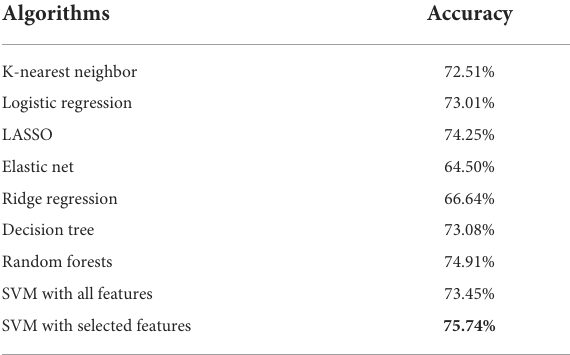
TABLE 4 Average classification accuracy of different algorithms for identifying